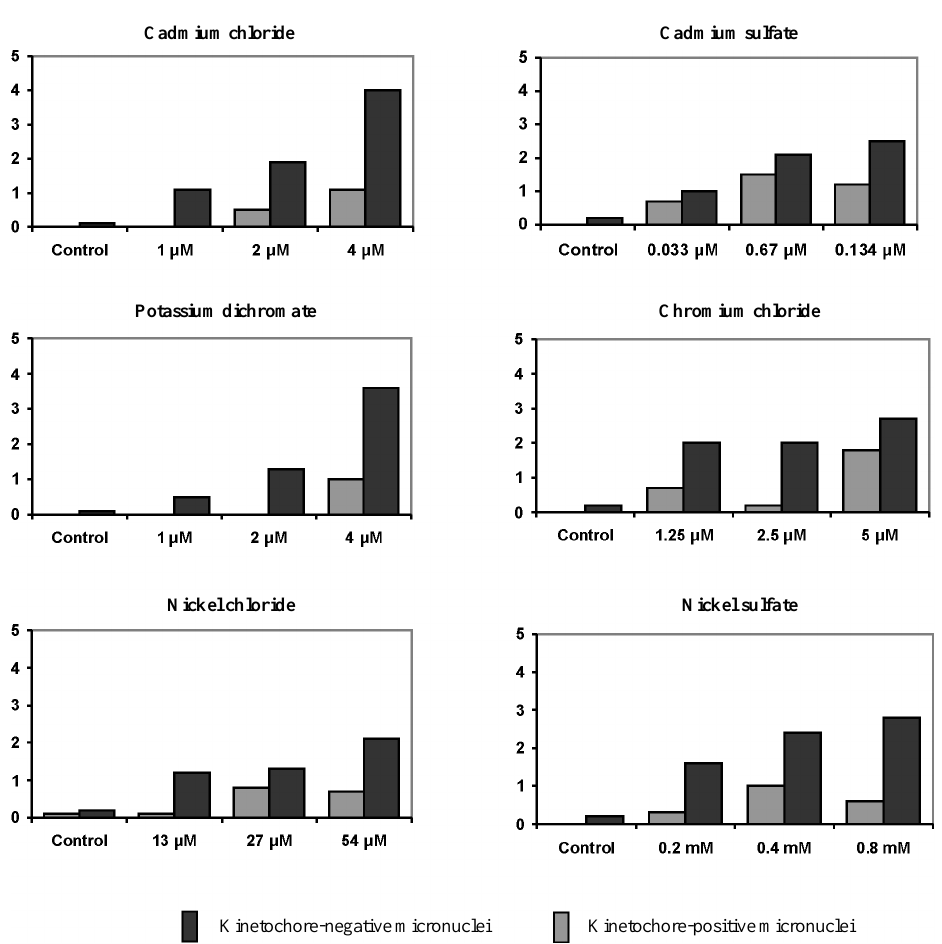
Figure 7 - Frequencies of kinetochore-negative and kinetochore-positive micronuclei in MRC-5 cells detected by using CREST